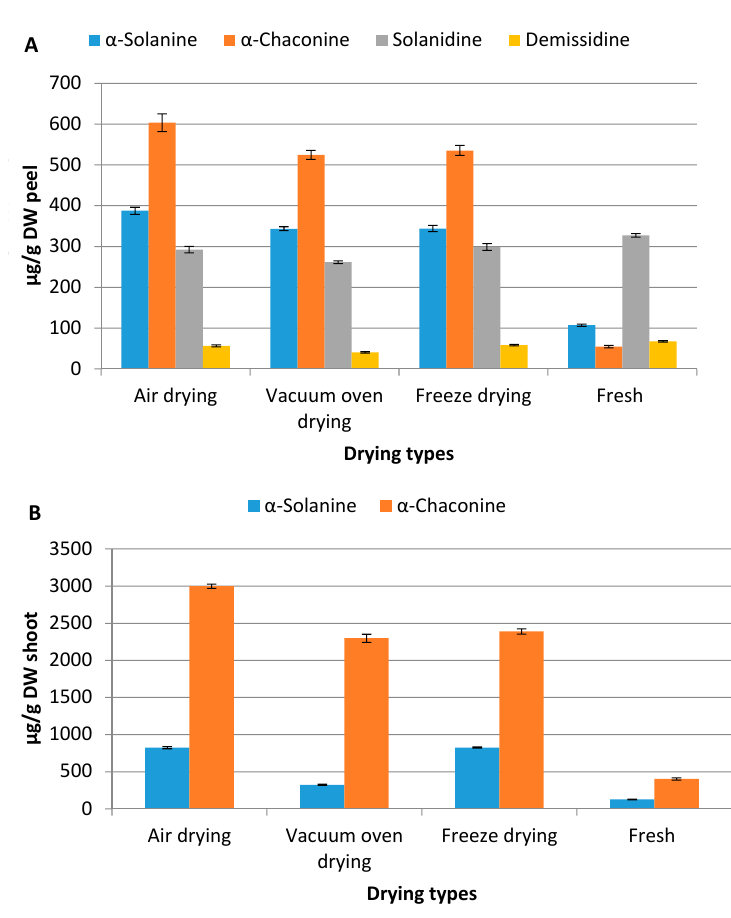
Figure 4. Levels of steroidal alkaloids in potato peel ( A ) and shoots ( B ) following different drying conditions (Error bars represent standard deviation, n = 6).